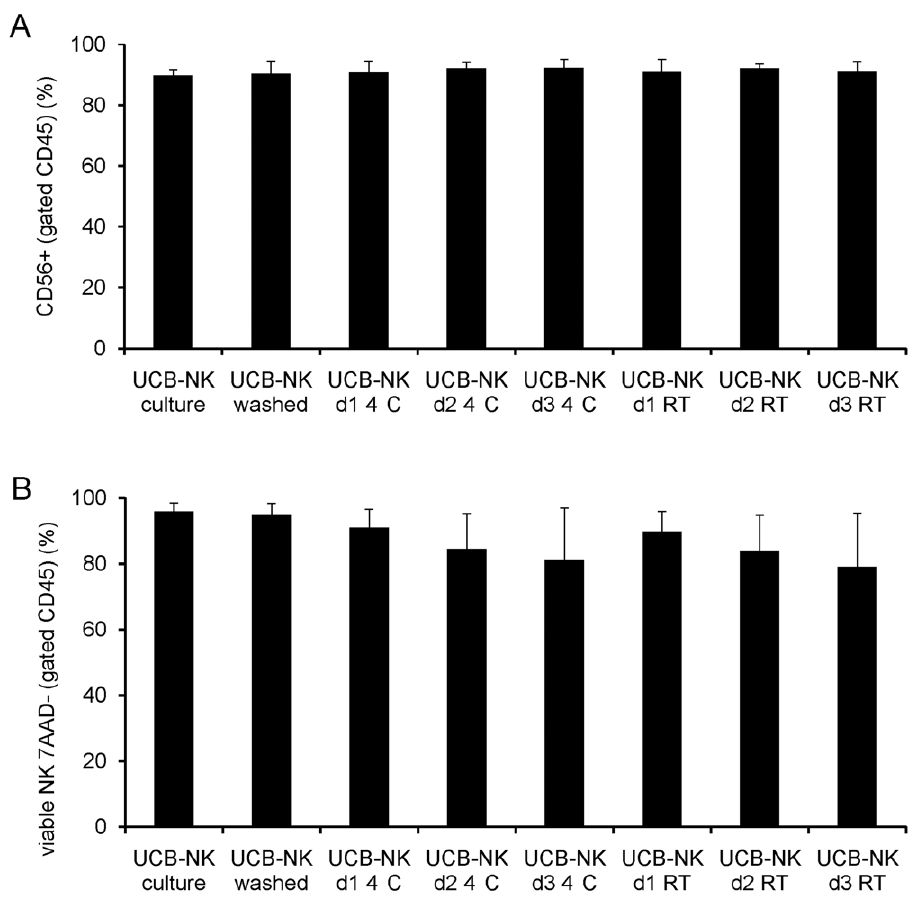
Figure 4. Stability tests of ex-vivo generated and processed NK cell products. ( A ) The NK cell content of the processed final product was followed over time, while the products were either stored at 4 u C or room temperature (RT) for a maximum of 3 days. The percentage of the CD45 + / CD56 + cells is displayed from 3 different stability tests. ( B ) Viability of the final NK cell product was followed over time, while the products were either stored at 4 u C or room temperature (RT). The percentage of the CD45 + /CD56 + /7-AAD 2 cells is displayed from 3 different stability